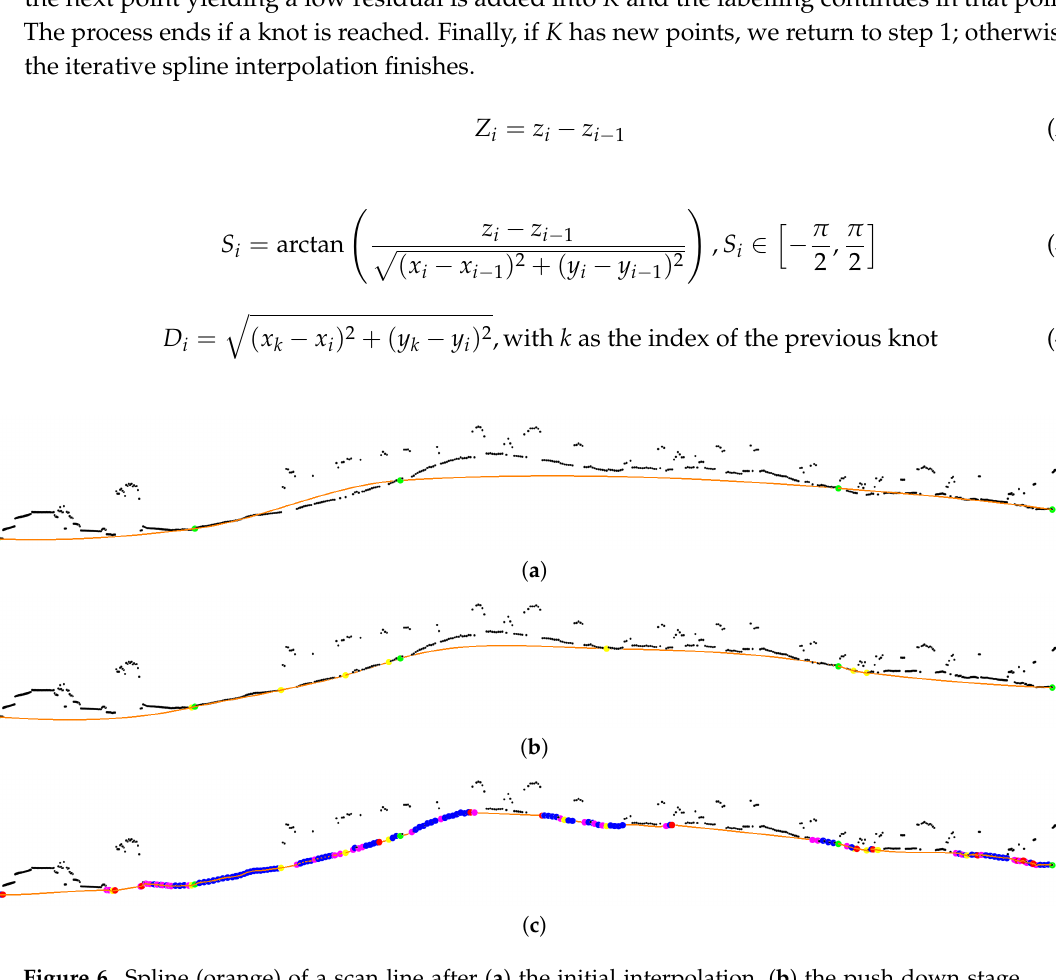
Figure 6. Spline (orange) of a scan line after ( a ) the initial interpolation, ( b ) the push down stage, and ( c ) the push up stage. The knots of each stage are also shown: seed knots (green), push down added knots (yellow), and push up added knots (blue, red and purple). The colours of the push up added knots match the different knot addition processes shown in Figure 7: p i (blue), p i − 1 (red) and p j (purple). These images, among others within the paper, have been captured with Olivia